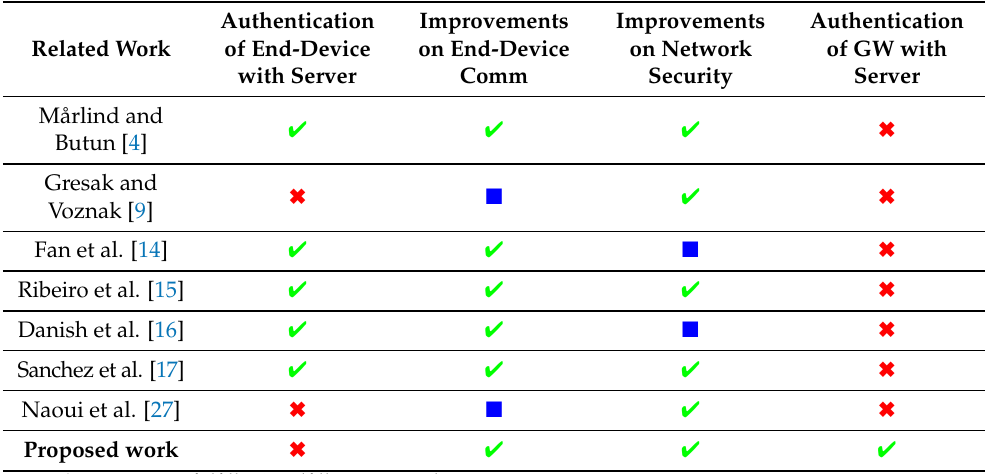
Table 3. Literature comparison of related security solutions for